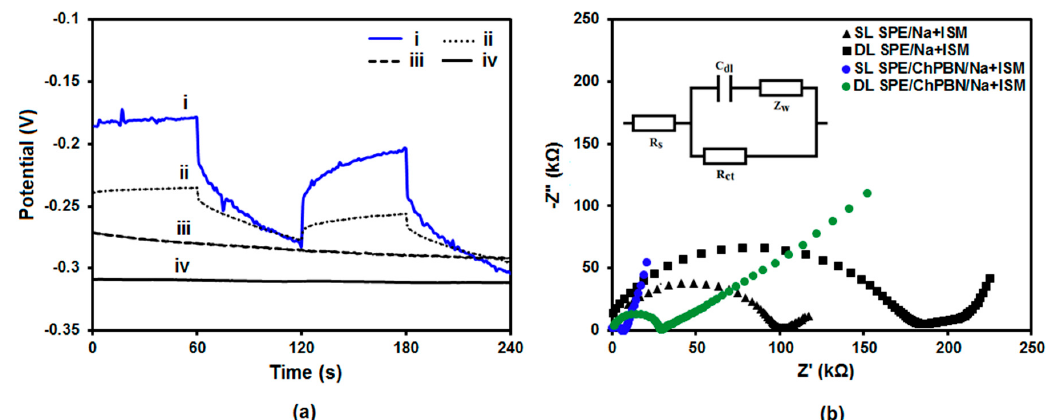
Figure 5. Potentiometric and impedimetric response of electrodes with and without ChPBN: ( a ) Anodic and cathodic chronopotentiometry plots for SPE/Na + ISE (Line i) and SPE/ChPBN/Na + ISE (Line ii) in 0.1 M NaCl at the periodically-alternating current of ± 100 nA. Chronopotentiometry polarization at ± 1 nA applied current before (Line iii) and after (Line iv) conditioning of SPE/ChPBN/Na + ISE in 0.1 M NaCl for 1 h; ( b ) Nyquist plots from EIS measurement of SPE/Na + ISE and SPE/ChPBN/Na + ISE in 0.1 M NaCl. SL and DL represent single layer and double layer of ChPBN, respectively. Inset: the Randles circuit proposed to fit the EIS experimental result using NOVA software (version 2.0.2; Metrohm Autolab B.V., Utrecht, The